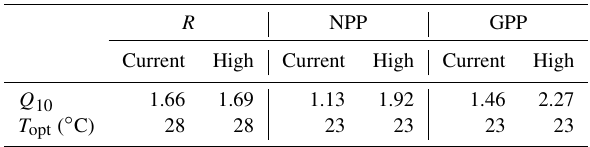
Table 2. Q 10 and T opt values for current and high- p CO 2 climates. R NPP